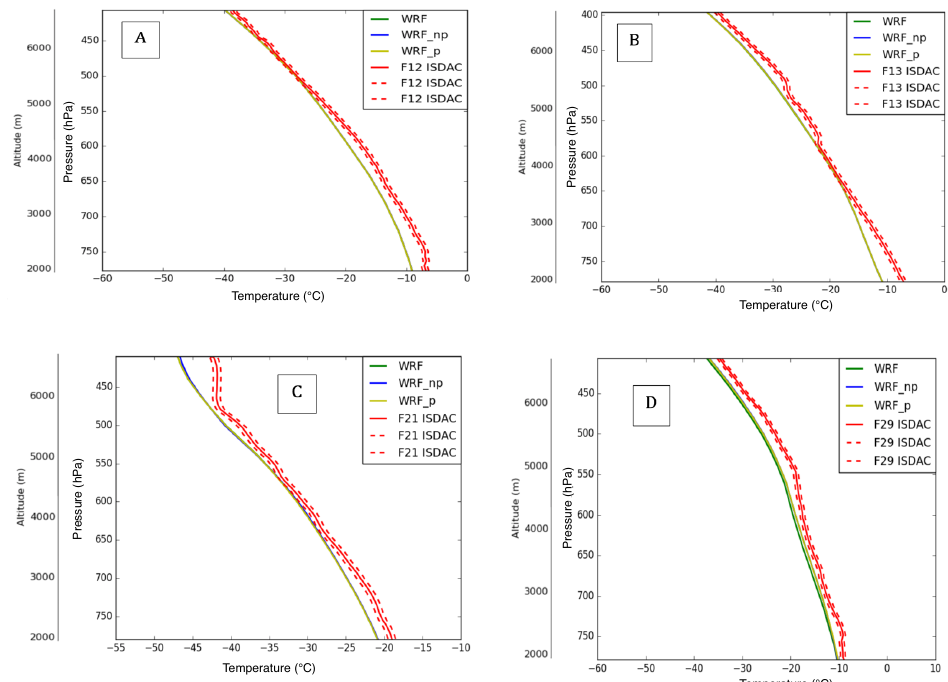
Figure 3. Comparison of the observed and simulated (WRF, WRF_np and WRF_p) vertical profiles of temperature (T) for the flights F12 ( A ), F13 ( B ), F21 ( C ) and F29 ( D ). The red solid and dashed lines represent the vertical profiles of the mean and standard deviation of T.